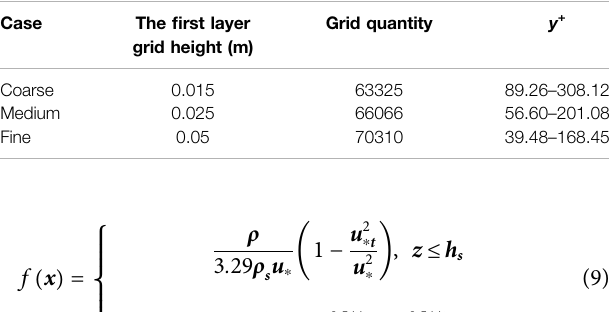
TABLE 3 | Speci fi cations of grid sensitivity